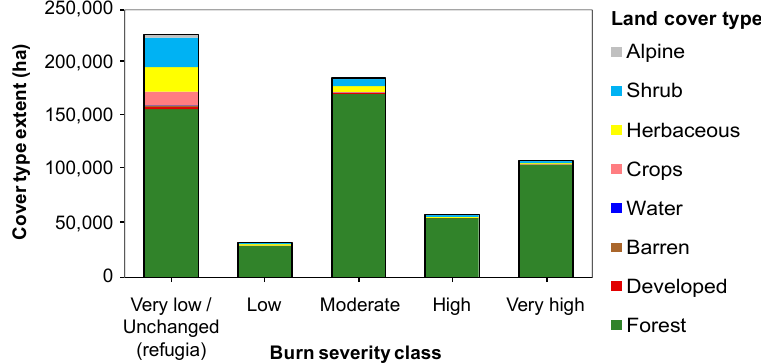
Figure 6. Pre-fire land cover across study fires according to GAP analysis data (https://gapanalysis.usgs.gov). Although these fires were predominantly forested (85%), a substantial portion of the refugia class was non-forested (31%). In addition, most of the non-forest extent (74%) was in refugia areas, and the most prevalent cover types in refugia were shrub (40%), herbaceous (33%), and crops (18%).